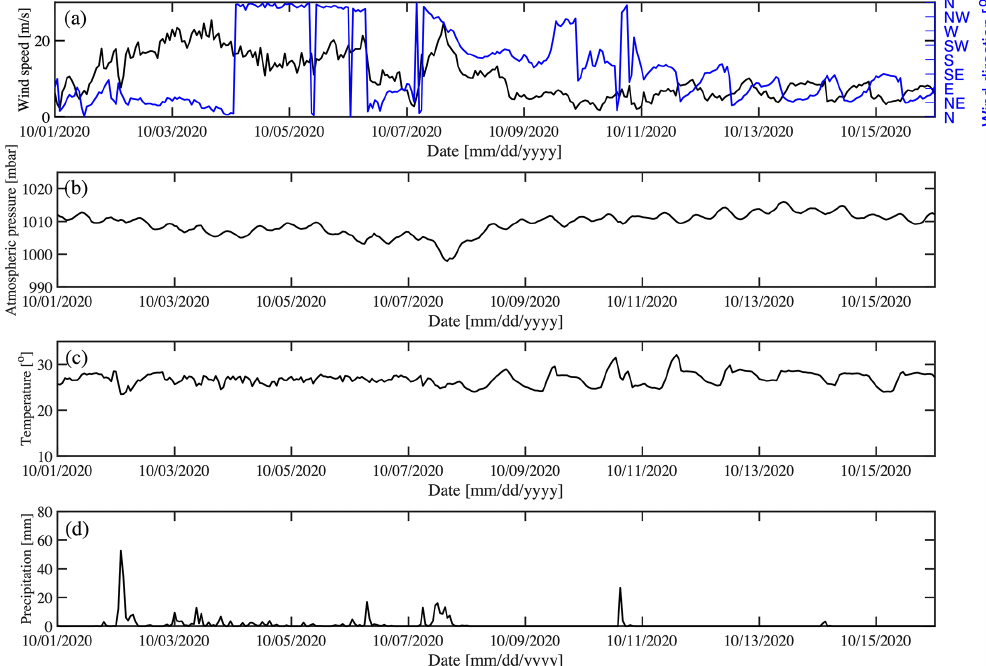
Figure 2. (a) Wind magnitude and direction, (b) atmospheric pressure, (c) air temperature, and (d) precipitation measured by the weather station at Sisal, Yucatán.